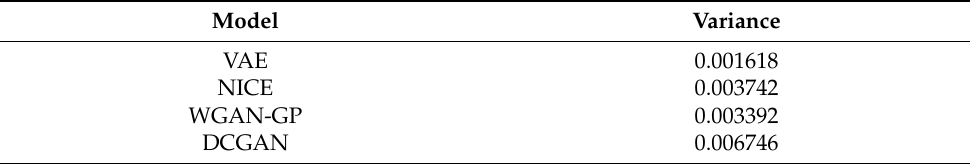
Table 5. The values of variance.